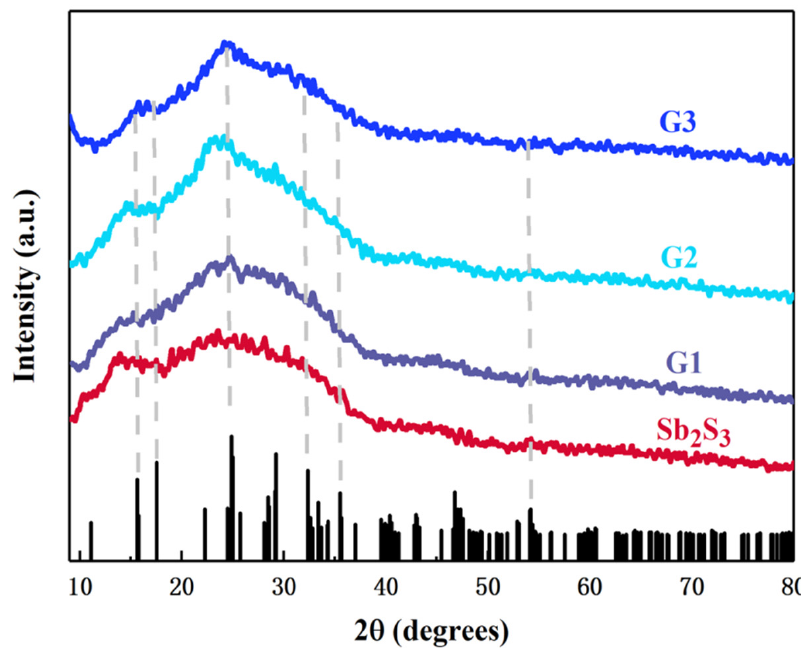
Figure 2. XRD patterns of the Sb 2 S 3 and Sb 2 S 3 /RGO (G1–G3).